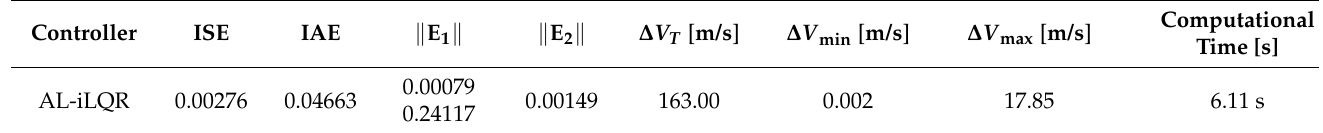
Figure 6. Relative docking angle evolution for LOS-constrained and unconstrained rendezvous using AL-iLQR. Table 3. Performance metrics for the LOS-constrained AL-iLQR